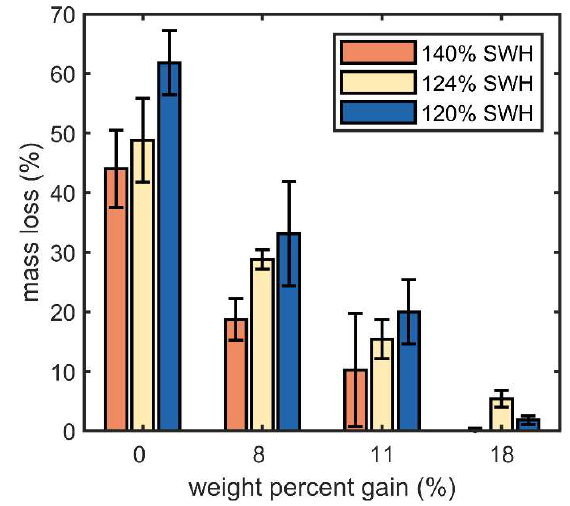
Figure 4. Percent weight loss caused by decay as a function of the soil water holding capacity and the level of acetylation. The error bars represent the standard deviation from five replicates.